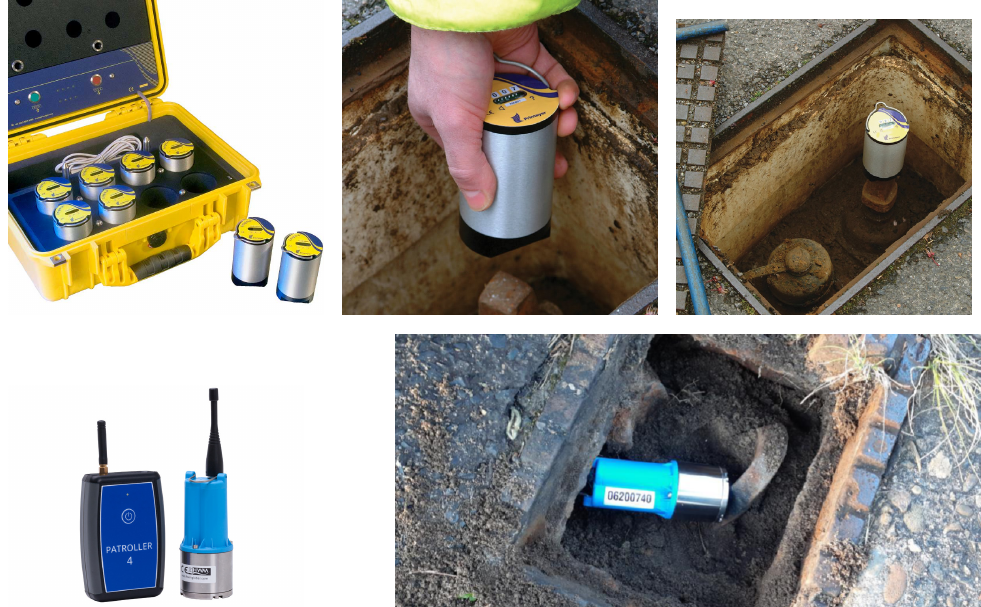
Figure 1. Primayer Enigma ( top ) and HWM PCorr+. ( bottom ) L&S correlating vibro-acoustic